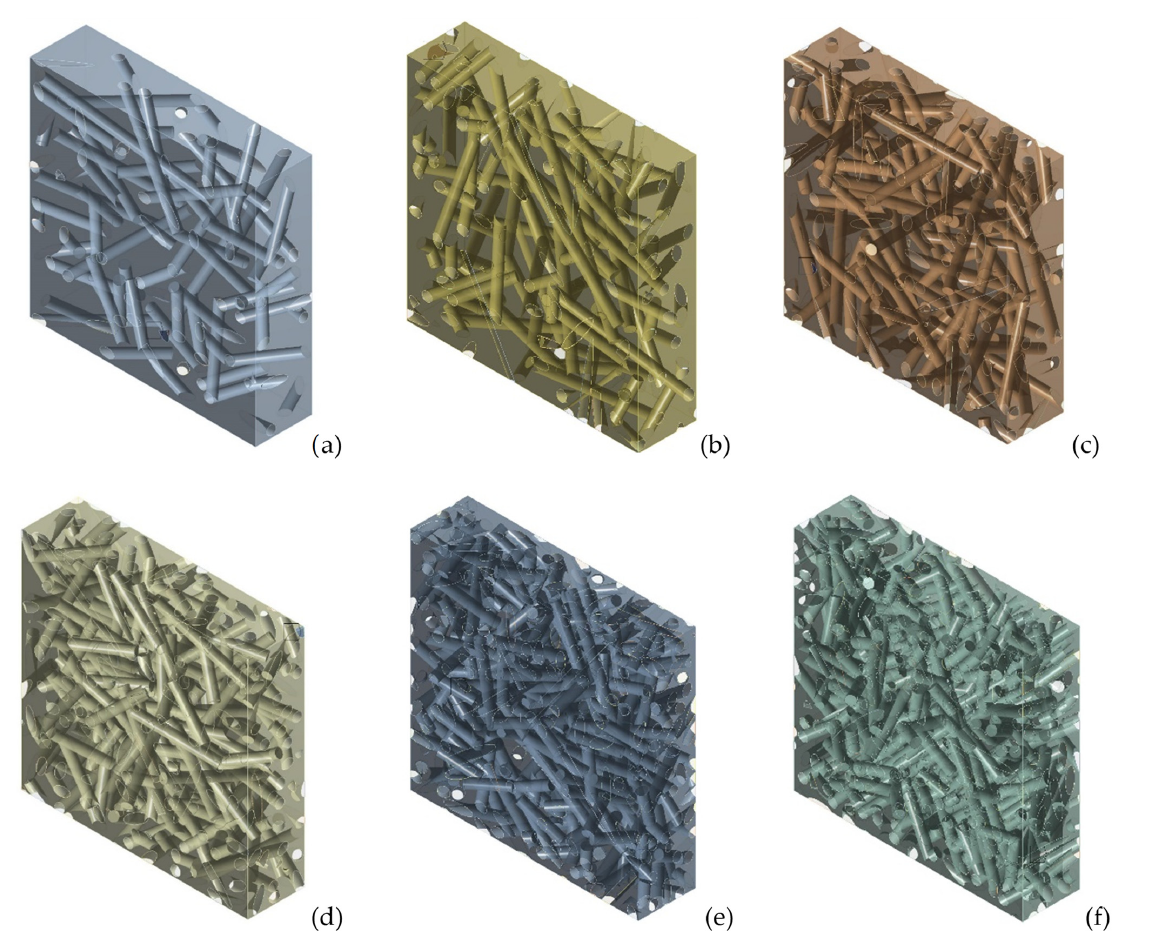
Figure 6. RVE of epoxy-short sisal fiber composites with variable V f : ( a ) 0.1, ( b ) 0.15, ( c ) 0.2, ( d ) 0.25, ( e ) 0.3, ( f ) 0.35.